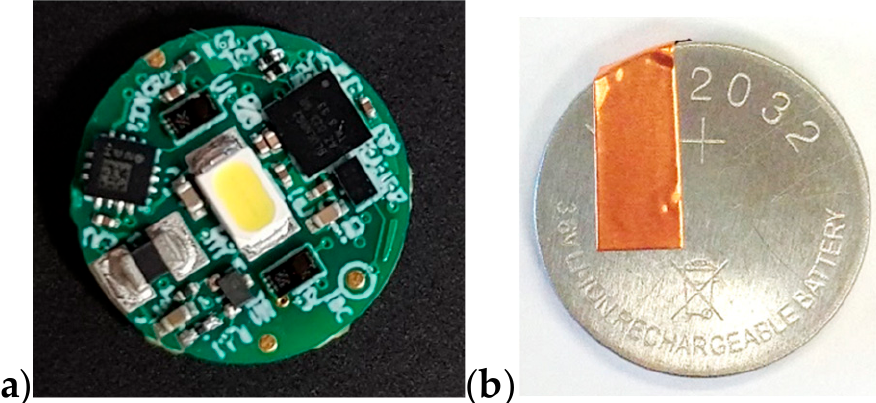
Figure 2. ( a ) Sensor board, ( b ) adapted LIR 2032 battery.